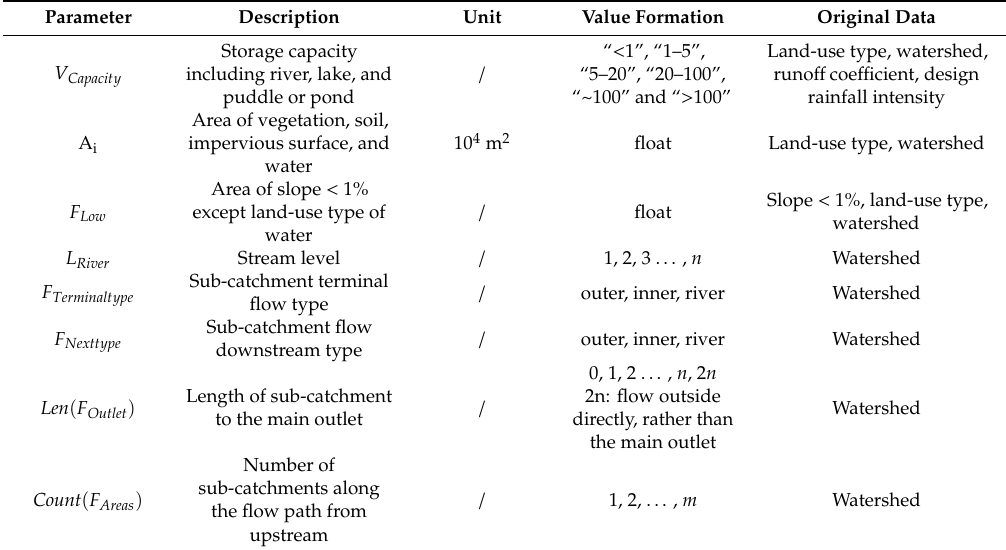
Table 2. The basic eight indicators need to be constructed. The V Capacity represents the rainwater storing ability of the sub-watershed. A i represents the ratio of VIS-W according to previous land-use type raster map. The F Low represents the low-lying area derived by slope and land-use type maps, which is related to the emergency of pumping outward. The L River is the stream level extracted by the accumulative flow. The other four indicators, including F Terminaltype , F Nexttype , Len ( F Outlet ) , and Count ( F Areas ) , are derived by the stream link and the main